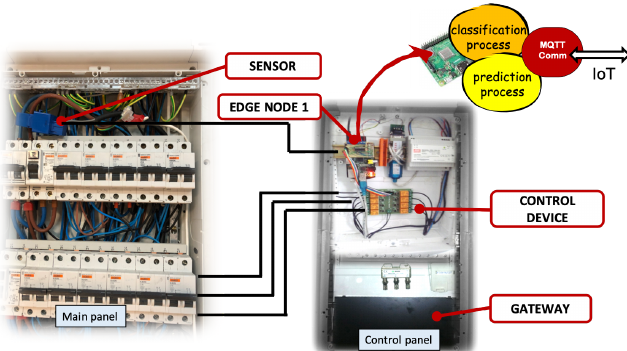
Figure 18. Experimental sub-system installed in the housing. The node can implement classification, prediction, and control algorithms proposed in the learning and operating phase.